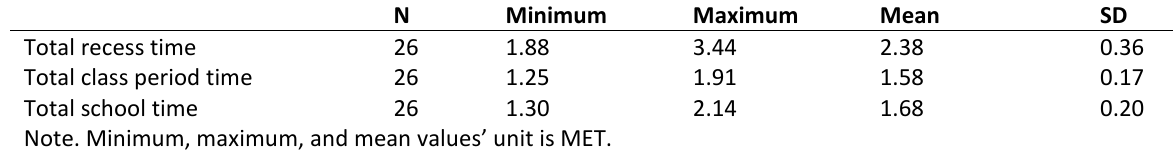
Table 1. Comparison of physical activity's intensity between recess time (breaks) and other significant periods